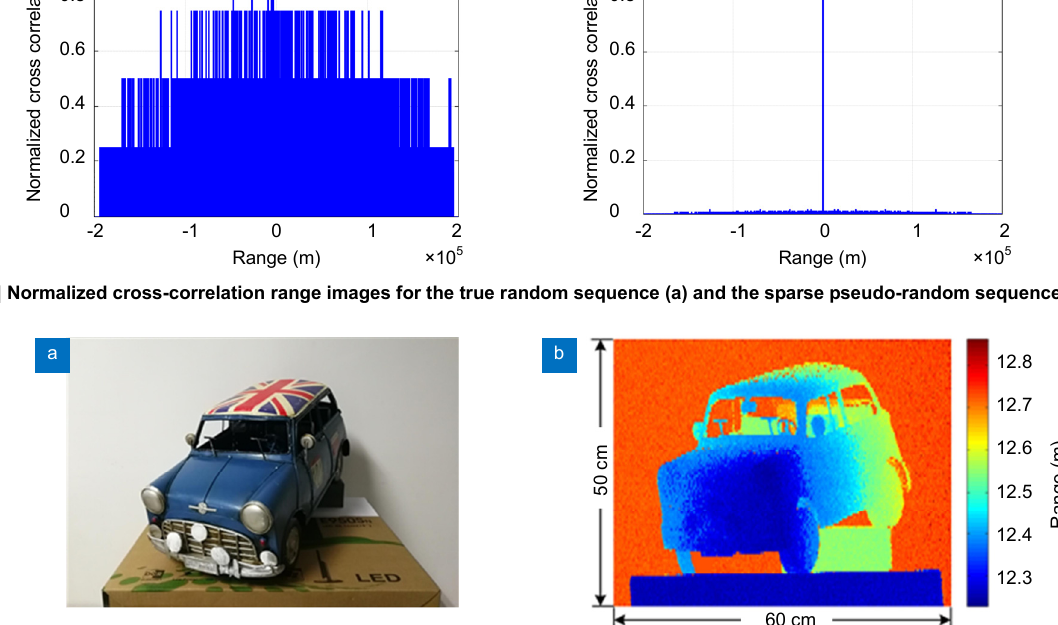
Fig. 7 | (a) The picture of the model car and (b) three-dimensional scanning imaging of the model car.